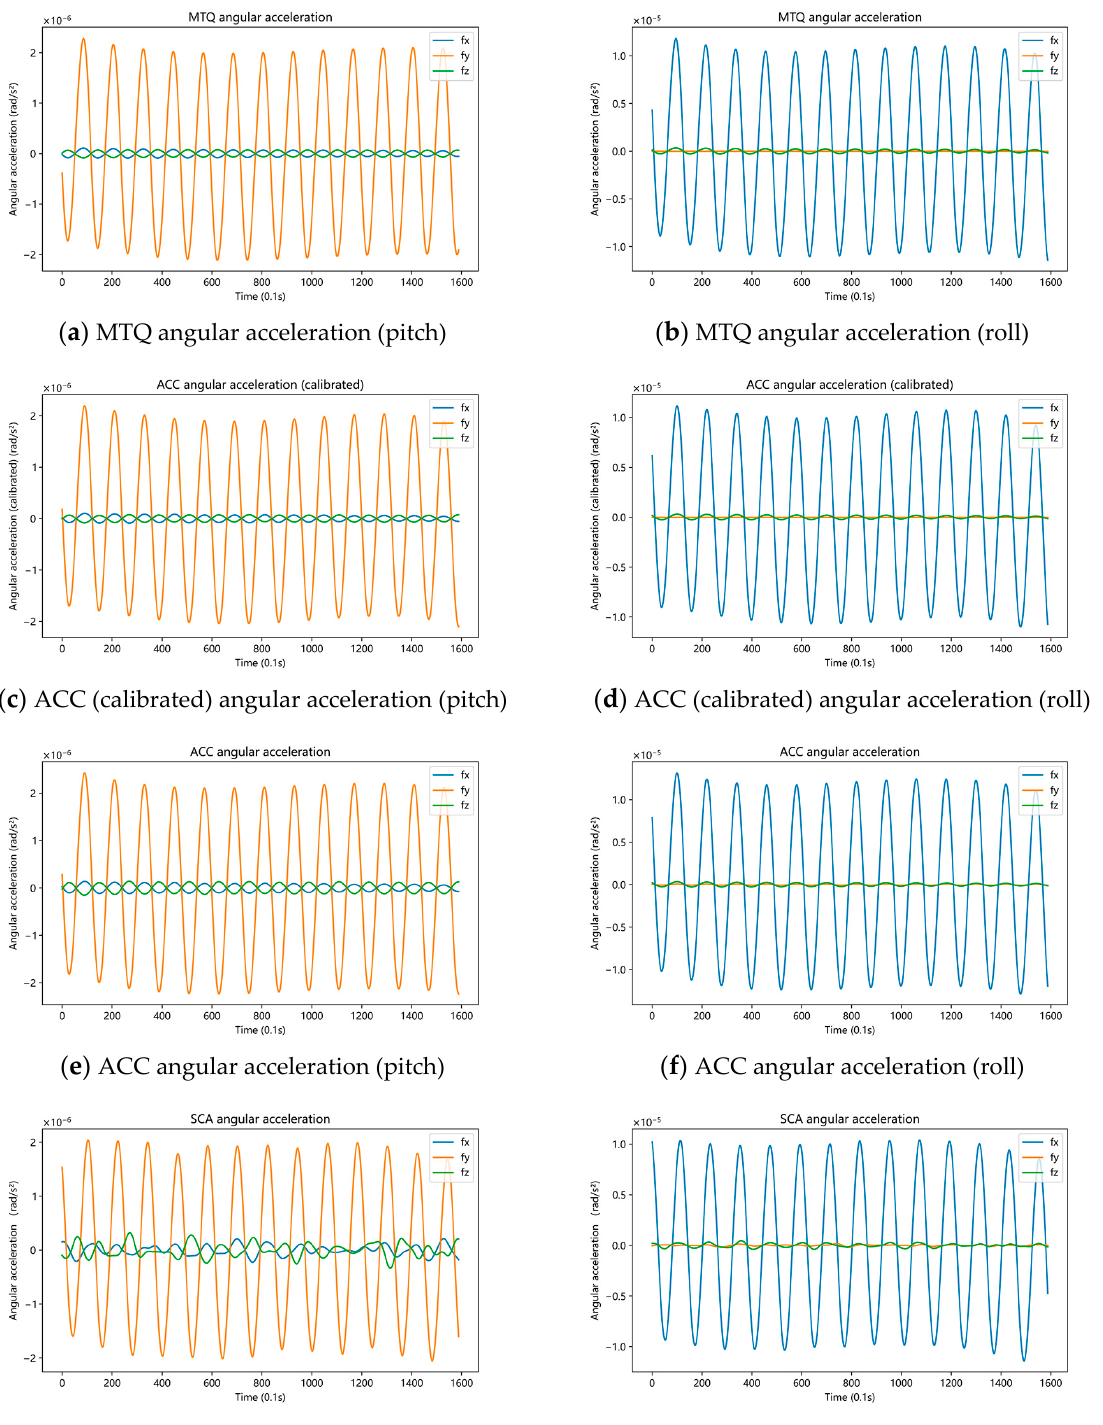
Figure 10. Four kinds of angular acceleration.